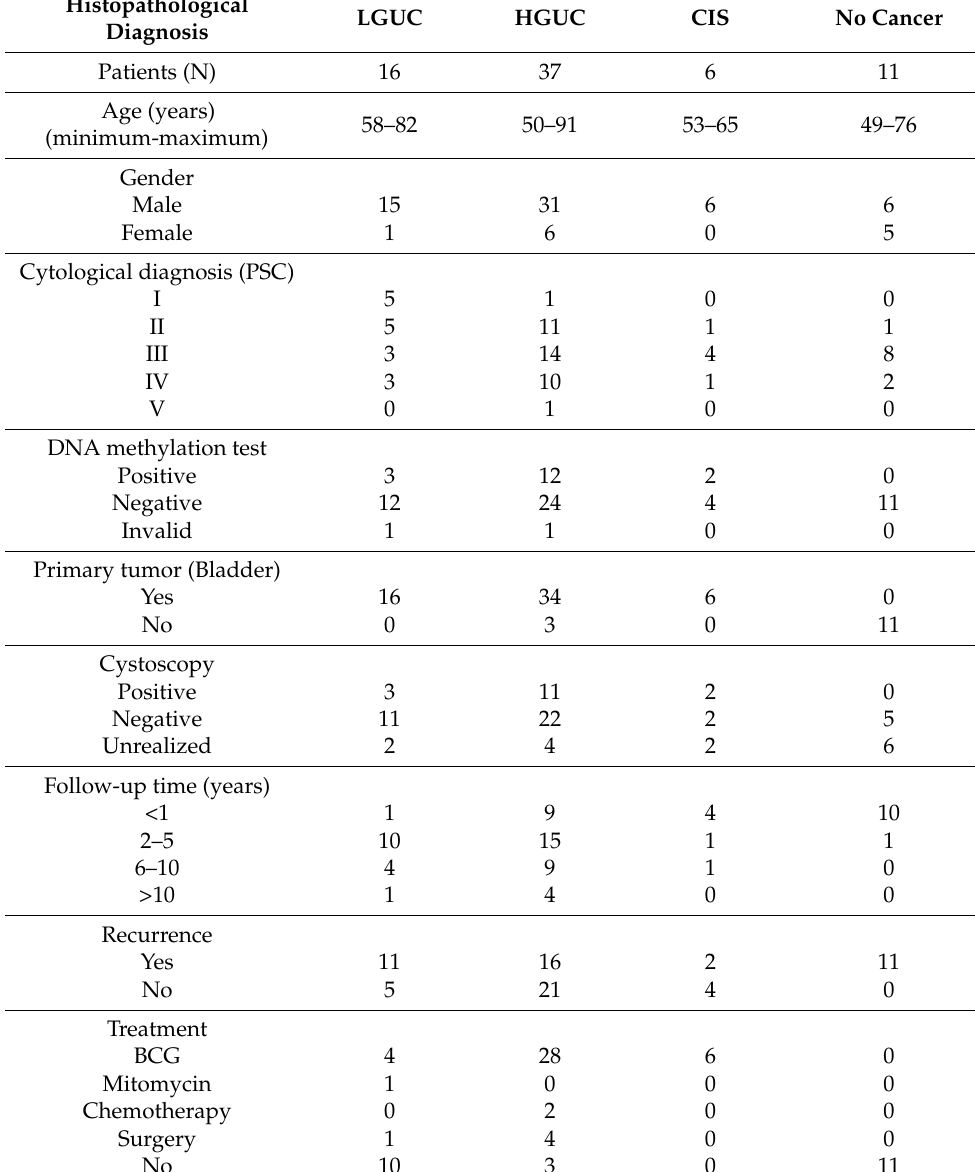
Table 1. Clinical characteristics of patients under investigation for DNA methylation test (N =